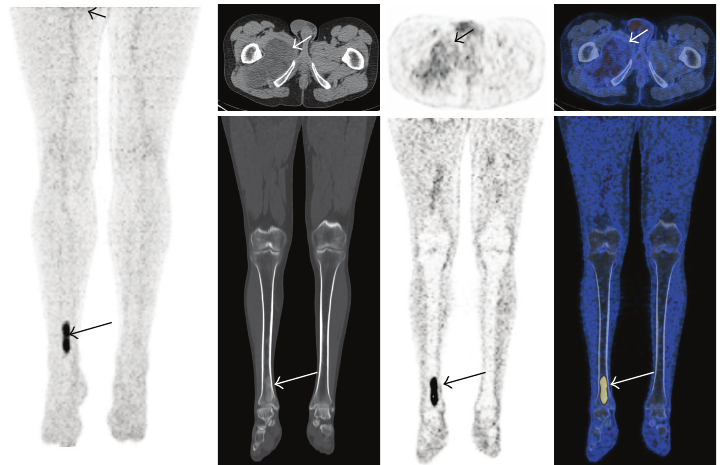
Figure 1: False positive 48 year old with a large myxoid liposarcoma of the right thigh (short arrow) with low metabolic activity (SUV 2.6) required biopsy to demonstrate that an avid (SUV 7.4) lesion of the right distal tibia (long arrow) was fibrous dysplasia.